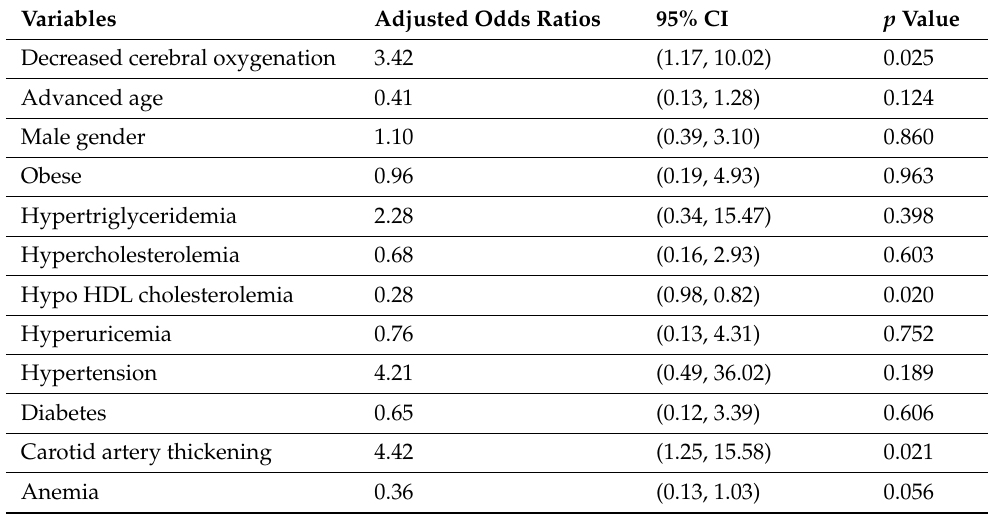
Table 5. Adjusted associations between chronic cerebral infarction and decreased cerebral